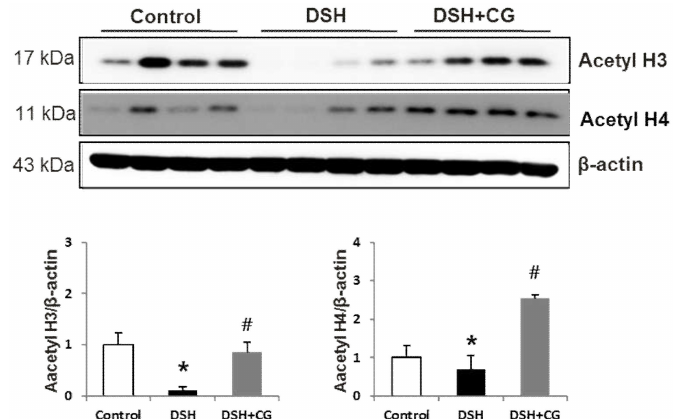
Figure 1. Semiquantitative immunoblotting analysis of acetyl H3 and acetyl H4 in the kidneys of experimental rats. Densitometric analysis revealed that the protein expression of acetyl H3 and acetyl H4 was decreased in deoxycorticosterone acetate (DOCA)-salt hypertensive rats (DSH) compared to that in controls, which was counteracted by CG200745 treatment (DSH + CG). * p < 0.05 compared to control. # p < 0.05 compared to DSH.